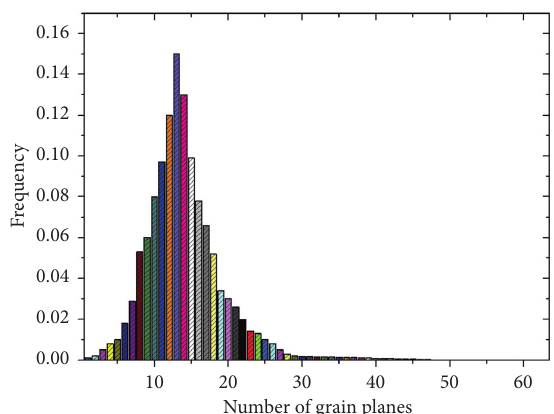
Figure 9: Distribution of the grain plane number at 420 °